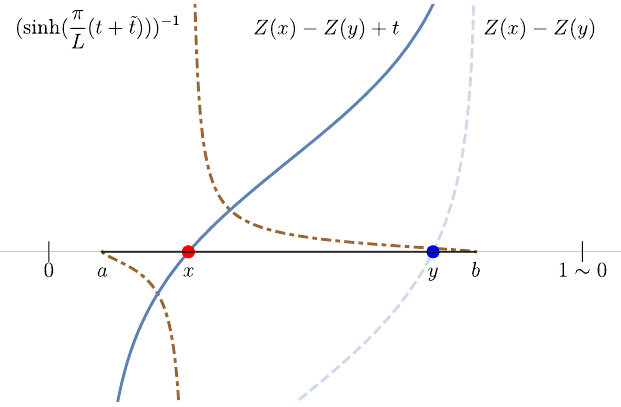
(cid:0) (cid:1) Figure 5 . Illustration of the modular flow σ t ψ † ( y ) of eq. (3.24) for the periodic sector on the cylinder — one of the novel results of this work — for a single interval, depicted in a similar manner as figure 4. Again the blue dot signals the point y , while the red dot follows the position of the local contribution to the flow, corresponding to the zero of Z ( x ) − Z ( y ) + t , for t = 0 (dashed- opaqued) and t > 0 (solid blue). The novelty is that in addition, this case contains a completely non-local term, as seen in the second term of (3.24), represented by the dot-dashed line that is proportional the non-local kernel. This vanishes at the endpoints and diverges at the position of the local